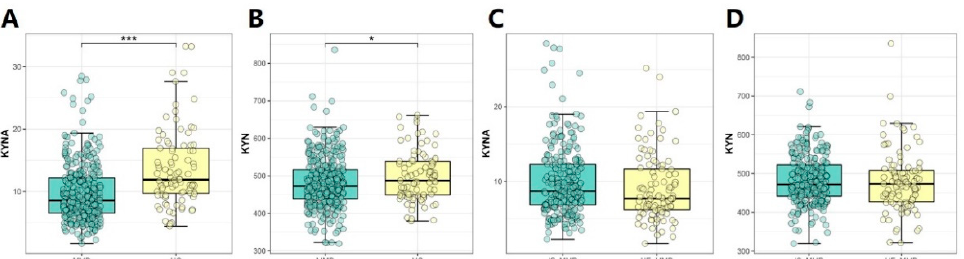
Figure 1. Comparison of serum KYNA and KYN levels between MMD patients/ischemic MMD and healthy controls/hemorrhagic MMD. ( A , B ) Serum KYNA and KYN levels were significantly different between MMD patients and healthy controls. *** p < 0.001; * 0.01 < p < 0.05. ( C , D ) Serum KYNA and KYN levels did not show differences between ischemic MMD and hemorrhagic MMD. MMD indicates moyamoya disease; HC, healthy controls; KYNA, kynurenic acid; KYN, kynurenine; IS_MMD, ischemic moyamoya disease; HE_MMD, hemorrhagic moyamoya disease. The unit of measurement is Table 1. Population characteristics among controls and MMD cases.